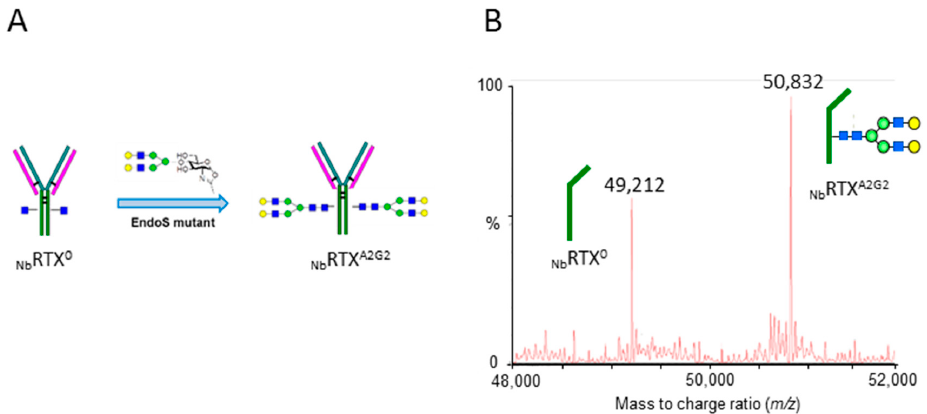
Figure 3. Chemoenzymatic transglycosylation of plant-made rituximab. ( A ) Schematic representation